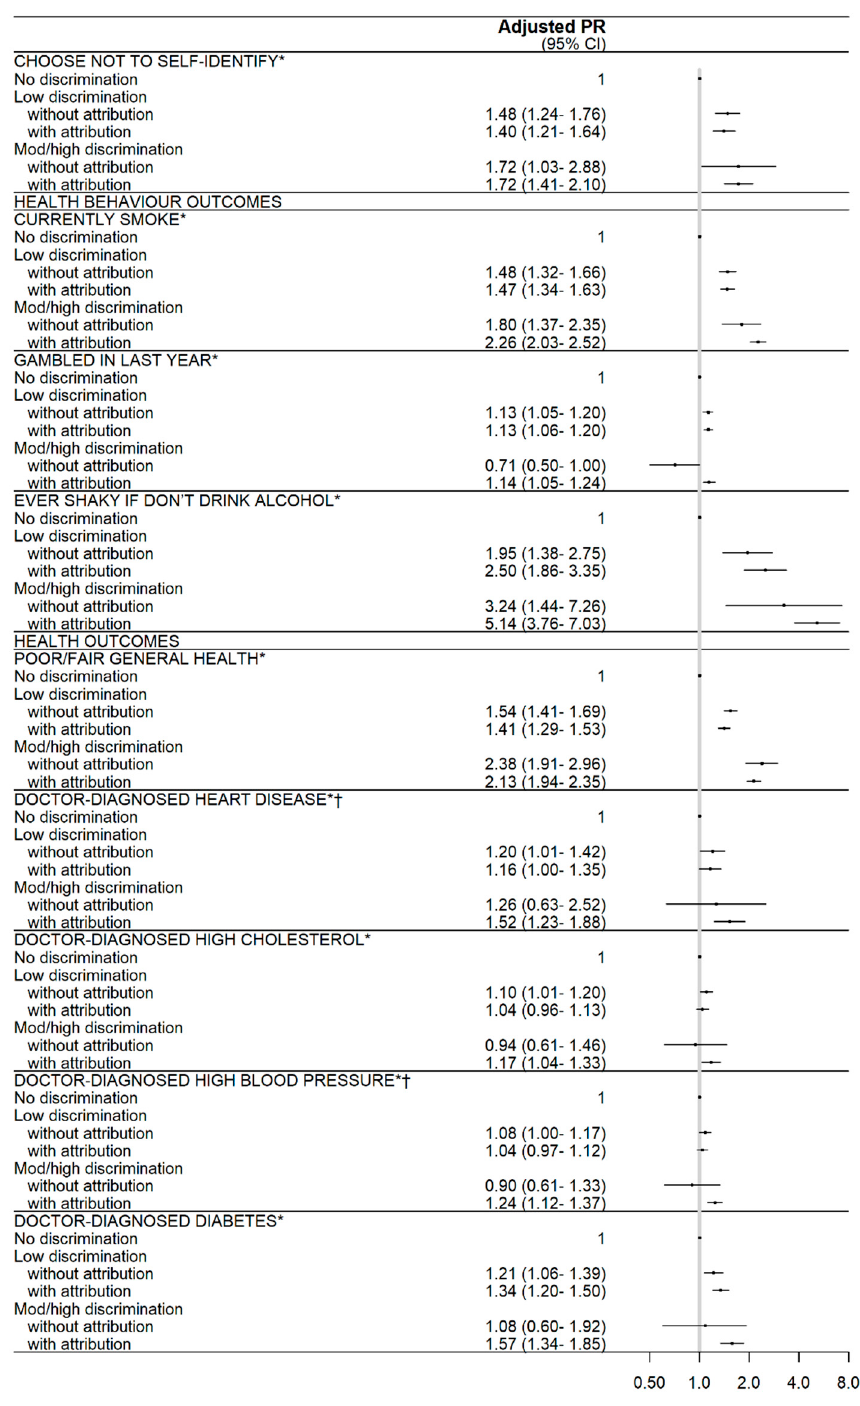
Figure 2. Relationship between experiences of everyday discrimination, with and without attribution to Indigeneity, and wellbeing outcomes ( n = up to 8039). The adjusted models are adjusted for age group, gender (male or female), and remoteness. Due to small numbers, participants identifying as another gender are excluded from all regression analyses as the models are adjusted for gender. All models exclude participants missing the outcome of interest. * Indicates that the overall discrimination score variable is significant in the adjusted model, with the p -value for the Wald test < 0.05. † Indicates that the adjusted model for the outcome (heart disease, blood pressure) employs a collapsed age categorisation (16–65 years, ≥ 66 years) due to small cells. See Table S3 for numbers of participants, unadjusted PR, and crude outcome prevalences by exposure category.